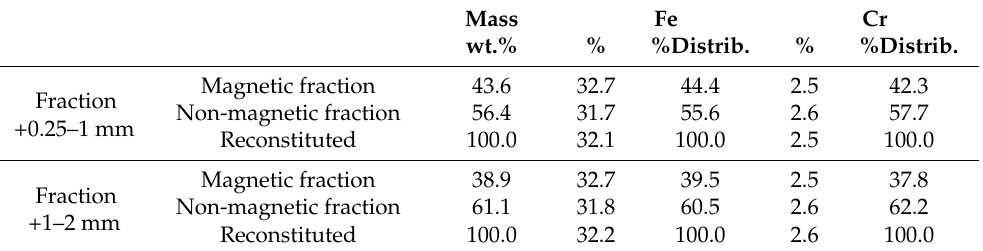
Table 3. Mass balance of the magnetic separation.